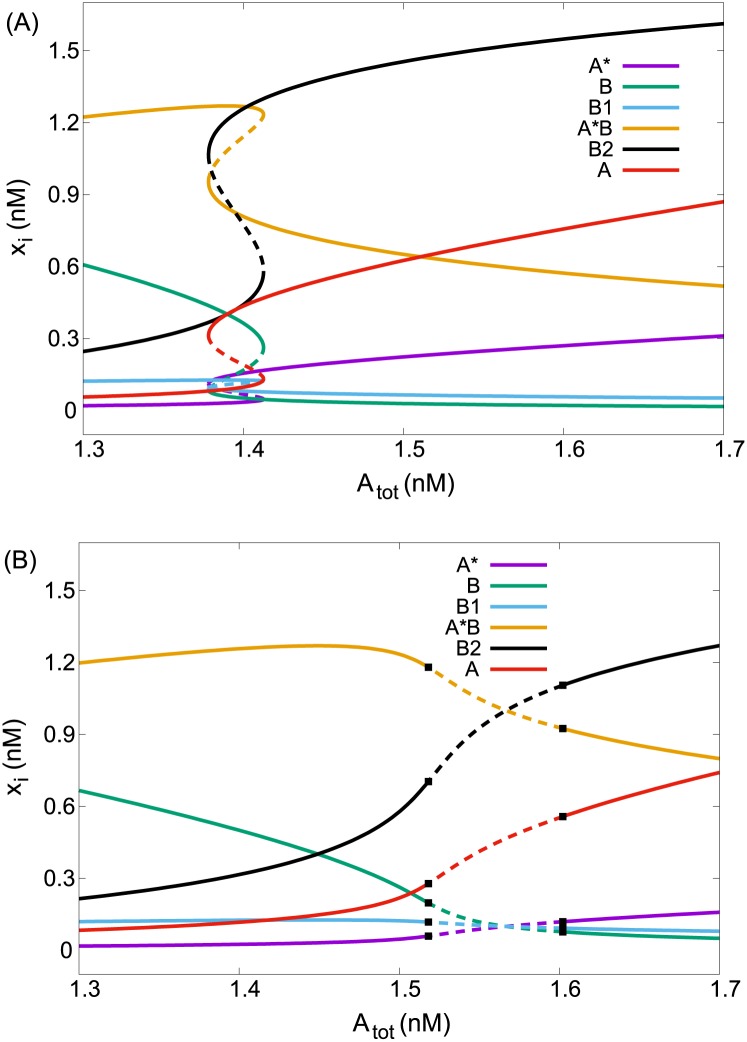
One-parameter bifurcation diagram.Dependence of the steady state values of all six components on Atot, (A) k6 = 0.25 s−1, (B) k6 = 0.15 s−1. Other parameters are given in text. Full line—stable, dashed line—unstable, black square—Hopf bifurcation.